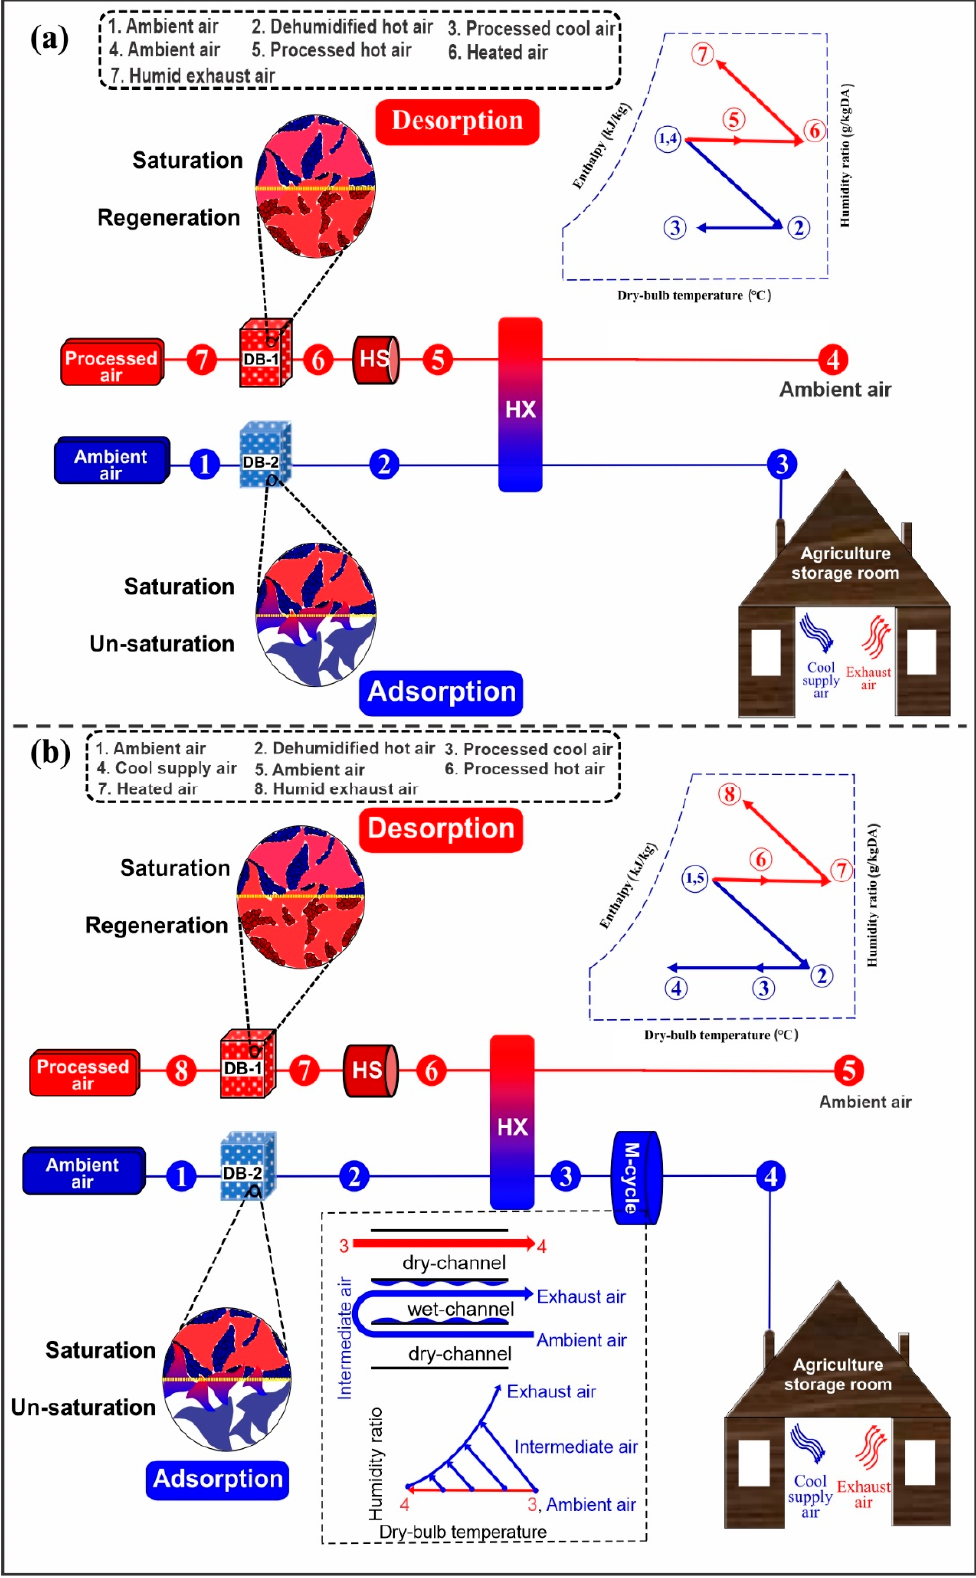
Figure 2. Schematic representation of ( a ) standalone desiccant air-conditioning (DAC) system and ( b ) Maisotsenko cycle (M-cycle)-based DAC system.